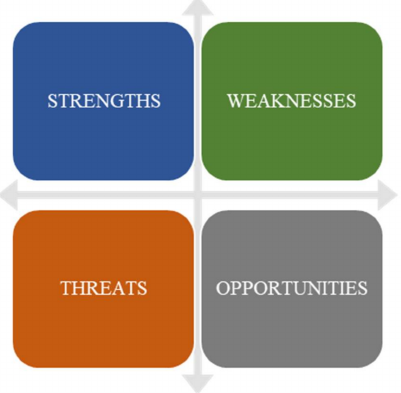
Figure 2. SWOT Panel. Source: Own